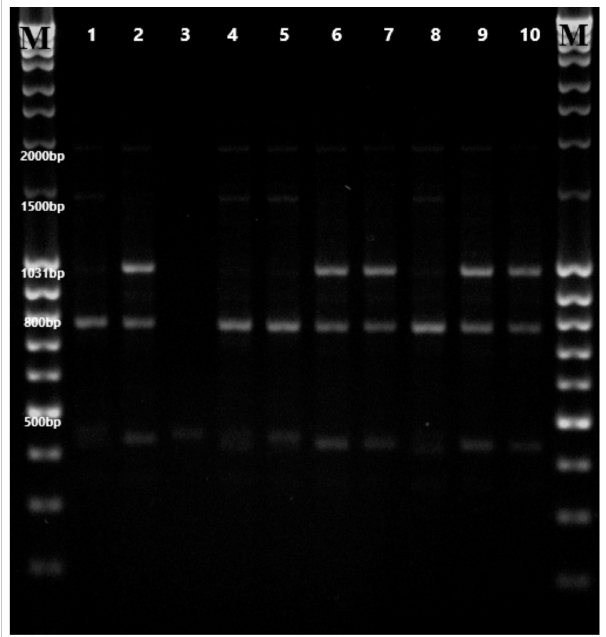
Figure 1. RAPD fingerprints of ten stevia genotypes using primer RAPD 2. M—standard of DNA fragment size GeneRulerTM DNA Ladder Mix (100–10,000